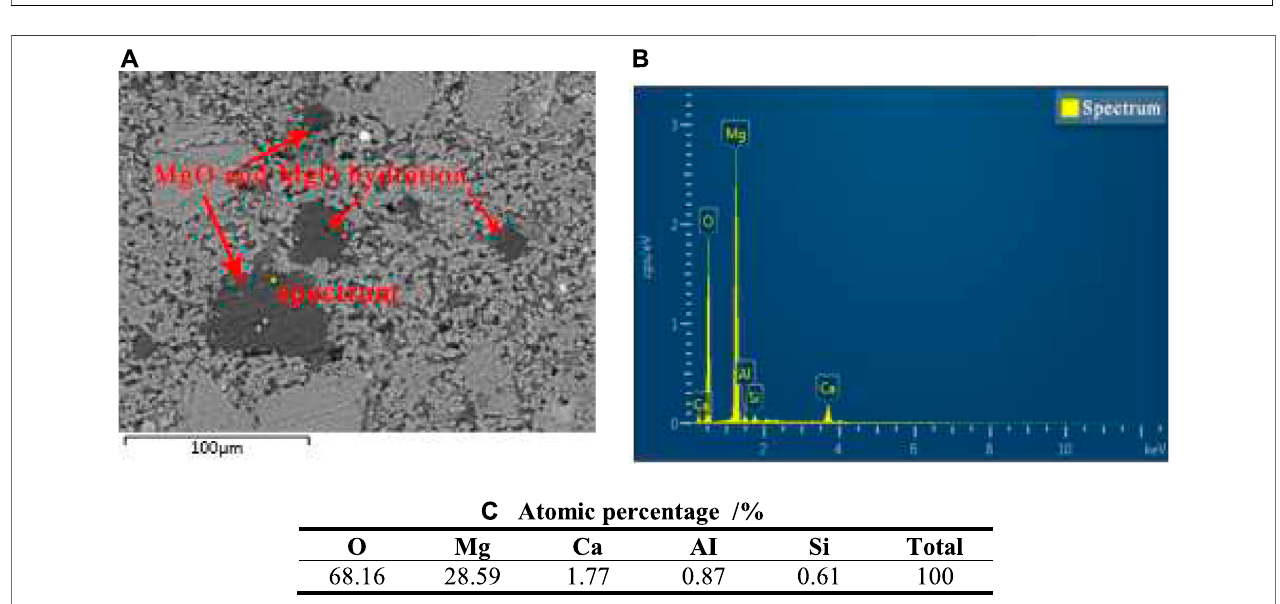
FIGURE 7 | Energy spectrum analysis diagram of a medium-size concrete specimen mixed with 10% MgO. (A) Backscattered electron image. (B) Micro-area composition of energy spectrum. (C) Atomic percentage.